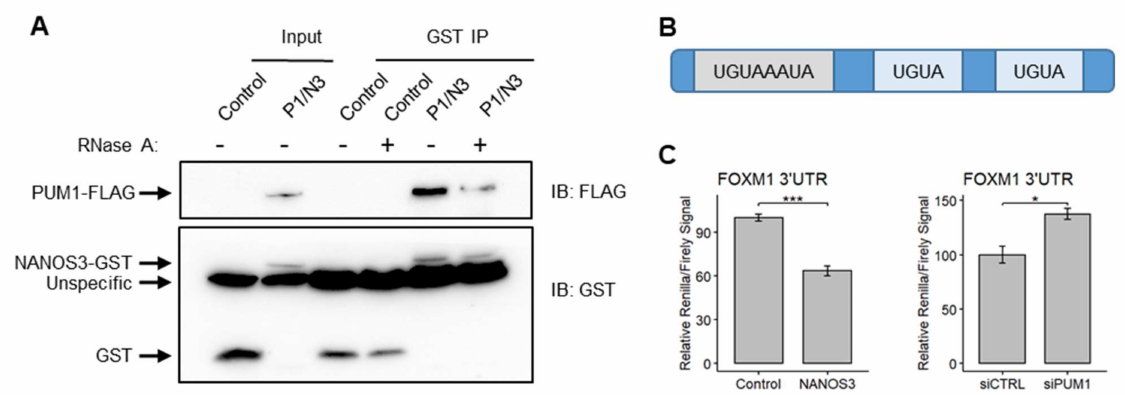
Figure 5. FOXM1 mRNA is regulated by the NANOS3/PUM1 post-transcriptional complex through its’ 3 (cid:48) UTR. ( A ) Western-blot visualization of GST pull-down of NANOS3 with and without RNase A. ( B ) Schematic representation of FOXM1 3 (cid:48) UTR containing the Pumilio binding element (PBE-UGUAHAUA) and 2 PBE-like motifs (containing core UGUA motif). ( C ) Dual luciferase as- say to measure Renilla/Firefly ratio upon PUM1 knockdown and NANOS3 overexpression using 3 (cid:48) UTR of FOXM1 in the downstream of Renilla ORF. Standard error is visualized as error bars. * = p -value ≤ 0.05, *** = p -value ≤